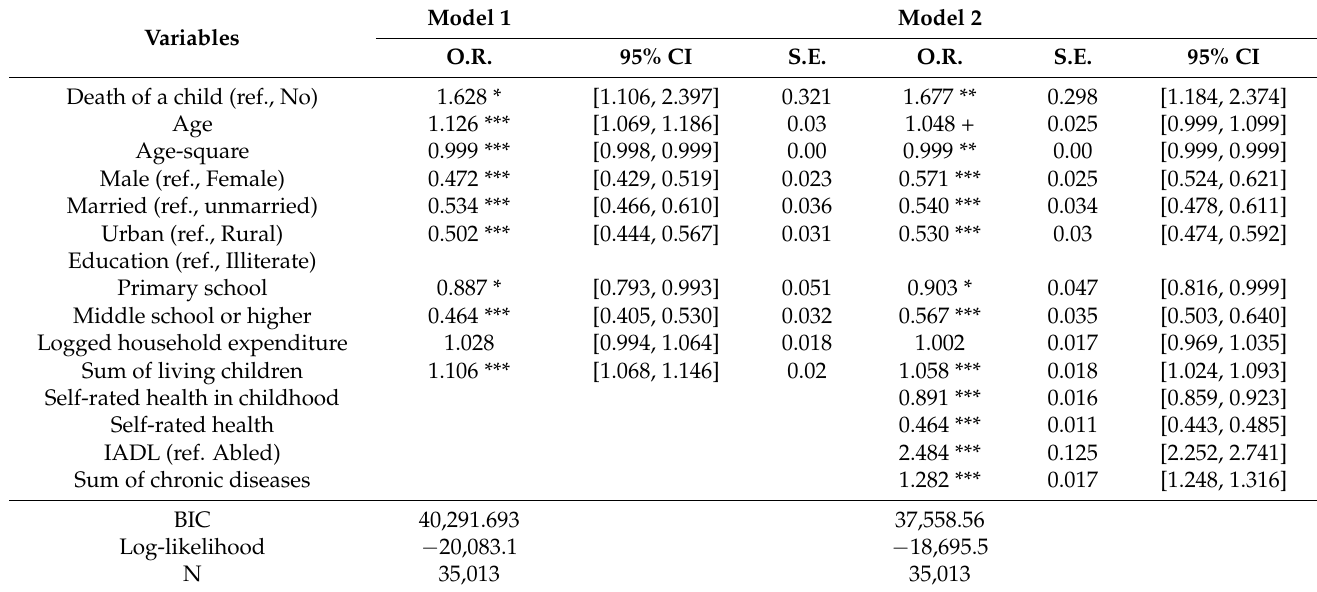
Table 2. Random-effects logistic regression models predicting parental depression by child